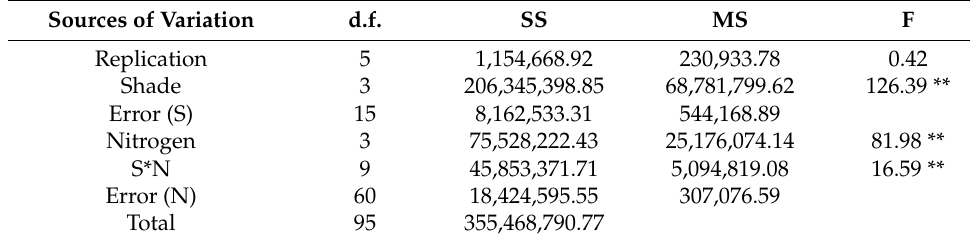
Table 3. Analysis of variance of wheat yield under the treatment of shading and N fertilizer. Sources of Variation d.f. SS MS F Replication 5 1,154,668.92 230,933.78 Shade 3 206,345,398.85 Error (S) 15